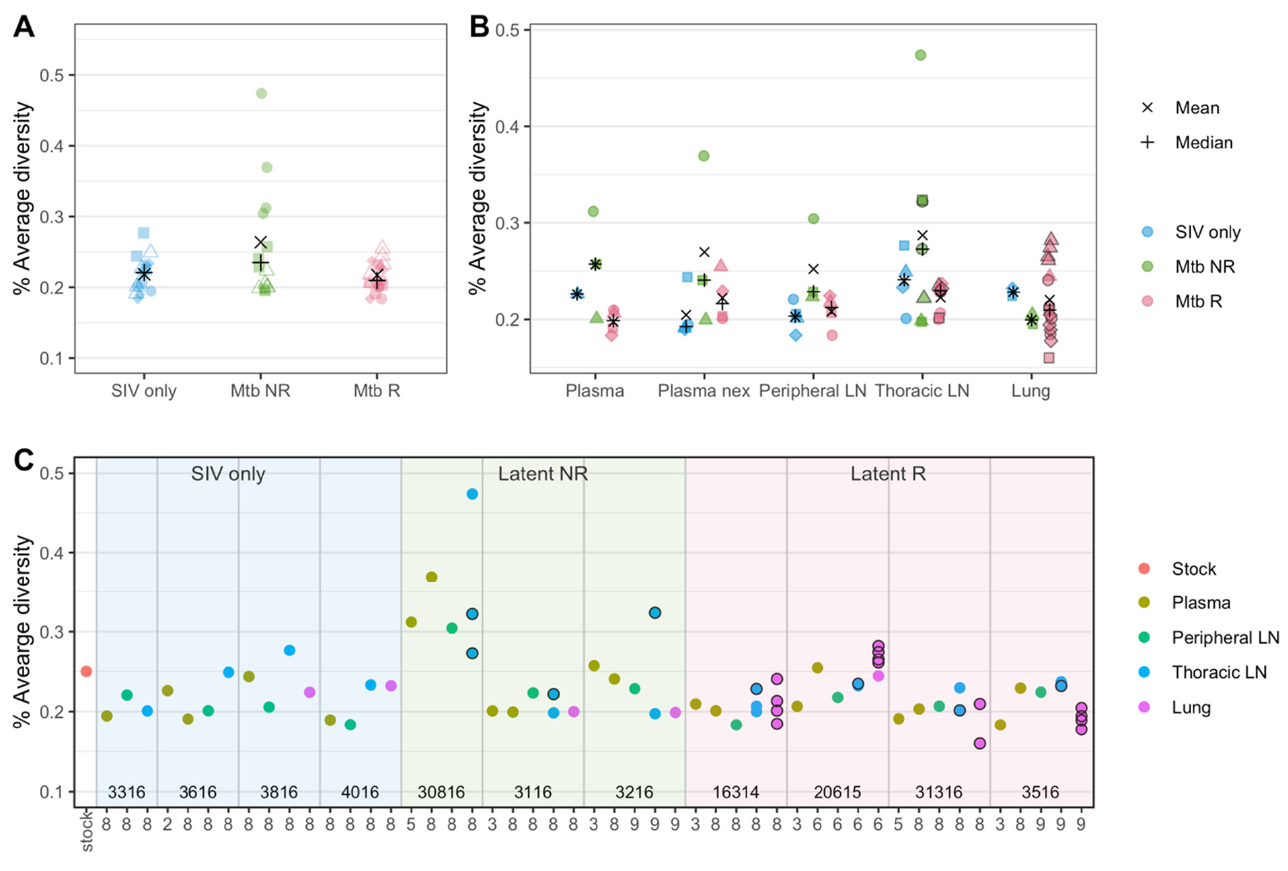
Figure 5. SIV nucleotide diversity in plasma and tissues. ( A ) Overall diversity of SIV in the three cohorts are shown. Here, all samples (all animals, all tissues and all time points) aggregated by cohort. Different shapes represent samples from different animals. ( B ) Diversity by each tissue type among the three cohorts are shown. Different shapes represent samples from different animals. ( C ) Genetic diversity of all available samples are shown, grouped by sample types in each animal. Animal numbers (listed in Table S1) are shown at the bottom and vertical lines distinguish animals. The x -axis represents the week post-infection from which each sample was obtained. Multiple samples were available for lungs and thoracic LNs in some animals and are shown in the same columns. ( B , C ) show the same samples as ( A ) (all animals, all tissues and all timepoints) but separatee by tissue type ( B ) and animal ( C ). Black bordered shapes in ( B , C ) represent samples in which a granuloma was identified at necropsy. ‘Plasma’ represent plasma samples at an early time point, and ‘Plasma nex’ represents plasma samples taken at